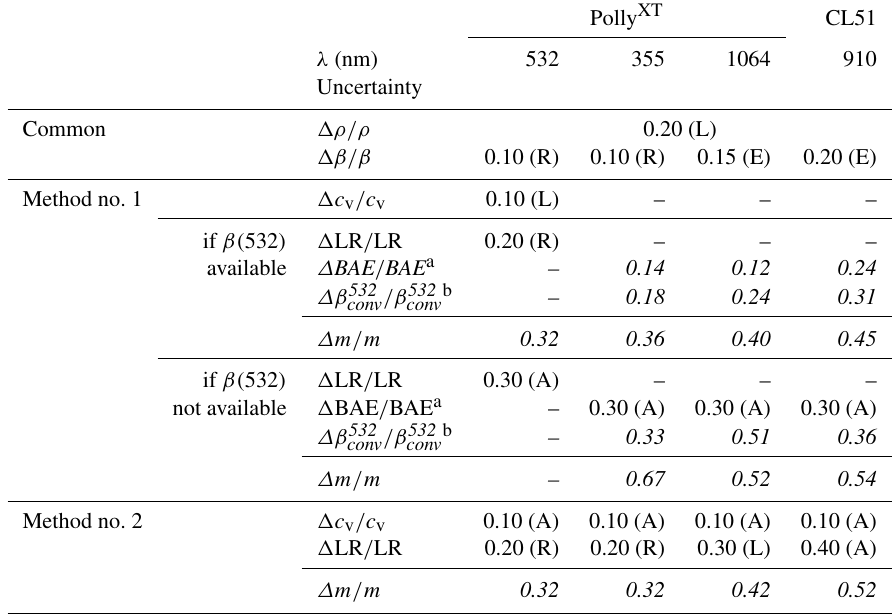
Table 3. Relative uncertainties in the input parameters and in the retrieved products (in italics). The uncertainty origins are given for input parameters and denoted as follows: R – Raman measurement available; E – only elastic measurement for the retrieval; L – literature; A – assumption. The uncertainty in the smoke mass density ( ρ ) was assumed to be 20% as in Ansmann et al. (2021). Different retrieval information (R or E) is available at each wavelength with a different system (Polly XT or CL51); thus different uncertainties in the backscatter coefficients ( β ) and lidar ratio (LR) are considered. The uncertainty in the smoke volume-to-extinction conversion factor ( c v ) was assumed as 10% for both methods, as given in Ansmann et al. (2021). The relative uncertainties in the mass concentration ( m ), backscatter-related Ångström exponent (BAE), and converted backscatter coefficient ( β 532 conv ) are obtained by the error propagation applied to Eqs.